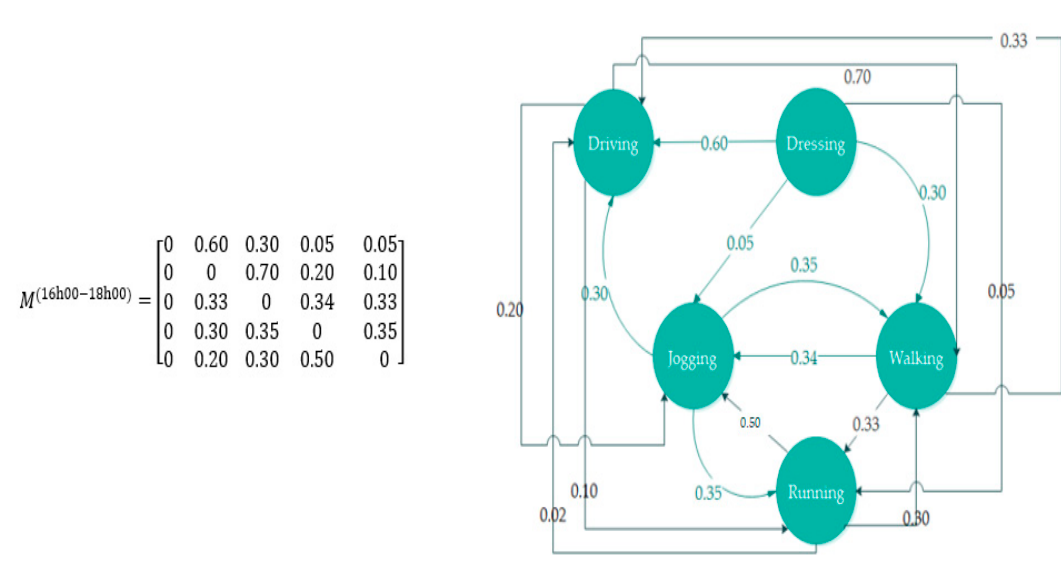
Table 4. Dataset: examples of activities.